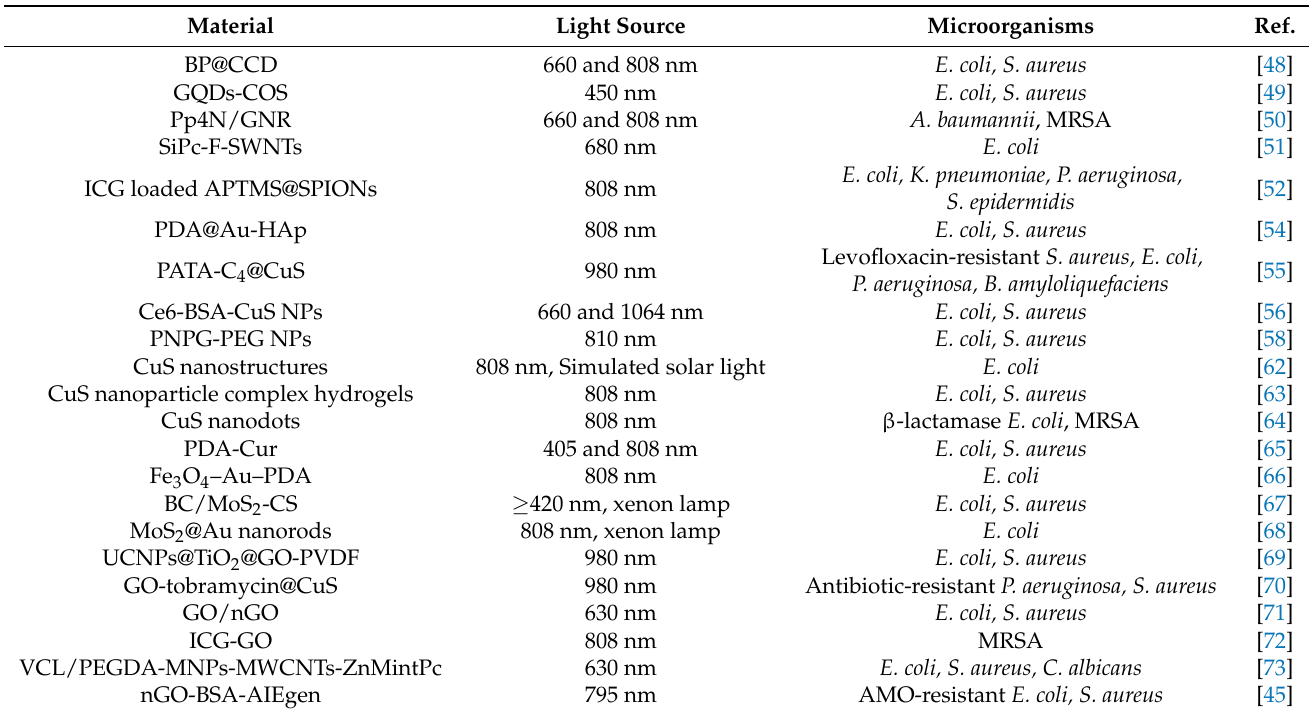
Table 1. Photothermal therapy (PTT)- and photodynamic therapy (PDT)-based synergistic antibacte- rial